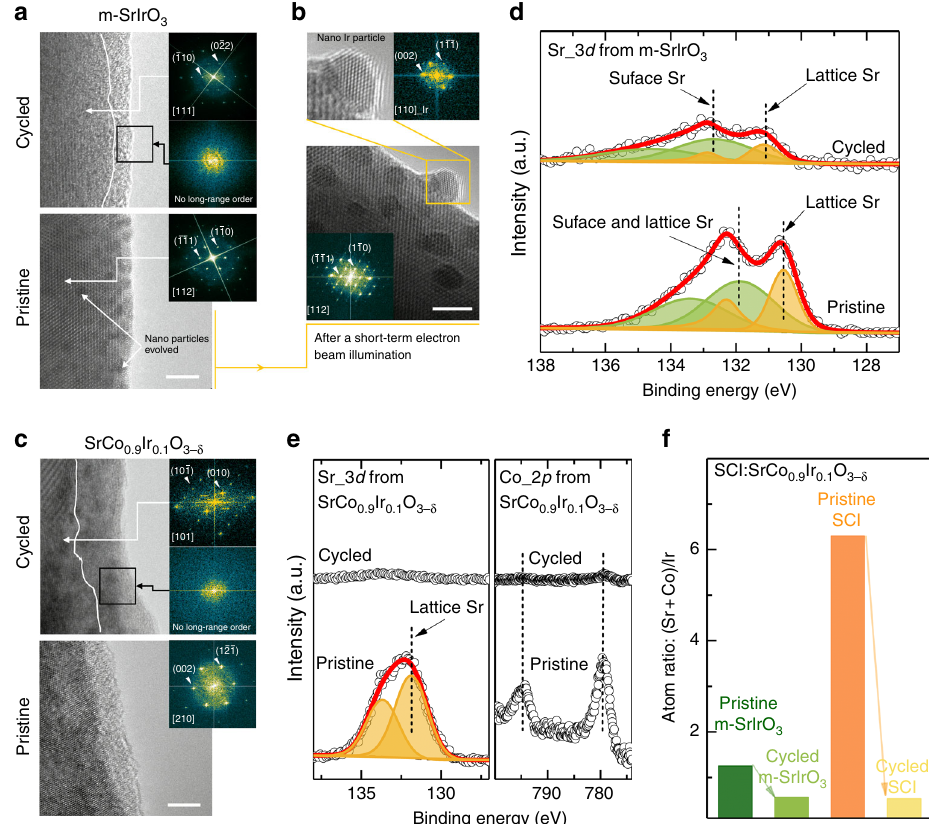
Fig. 2 Analysis of surface structure reconstruction. a High-resolution transmission electron microscopy (HRTEM) images of pristine and cycled m-SrIrO 3 (by 5 cycles, scale bar, 5 nm). b The HRTEM image of the exsolution of nanoparticles with increased size from m-SrIrO 3 after a short-term electron beam illumination. The fast Fourier transformed (FFT) pattern from the nanoparticle can be indexed to a F m 3 m space group of Ir metal. The exsolution of nano Ir particles has no apparent effect on the crystallinity of surface region. c HRTEM images of pristine and cycled SrCo 0.9 Ir 0.1 O 3 − δ (by 5 cycles, scale bar, 5 nm). The white curves in a and c indicate the interfaces between the crystallized region and the reconstructed region. The FFT patterns from the bulk of corresponding HRTEM images can be well indexed based on space groups of C 2/c for m-SrIrO 3 and P nma for SrCo 0.9 Ir 0.1 O 3 − δ . As re fl ected in the FFT patterns from the surfaces of cycled m-SrIrO 3 and cycled SrCo 0.9 Ir 0.1 O 3 − δ , no long-range order exists in the surface regions. d Sr_3 d XPS for m-SrIrO 3 before and after 5 cyclic voltammetry (CV) cycles. e Sr_3 d and Co_2 p XPS for SrCo 0.9 Ir 0.1 O 3 − δ before and after the electrochemical tests. f The surface (Sr + Co):Ir ratio in m-SrIrO 3 and SrCo 0.9 Ir 0.1 O 3 − δ before and after the electrochemical